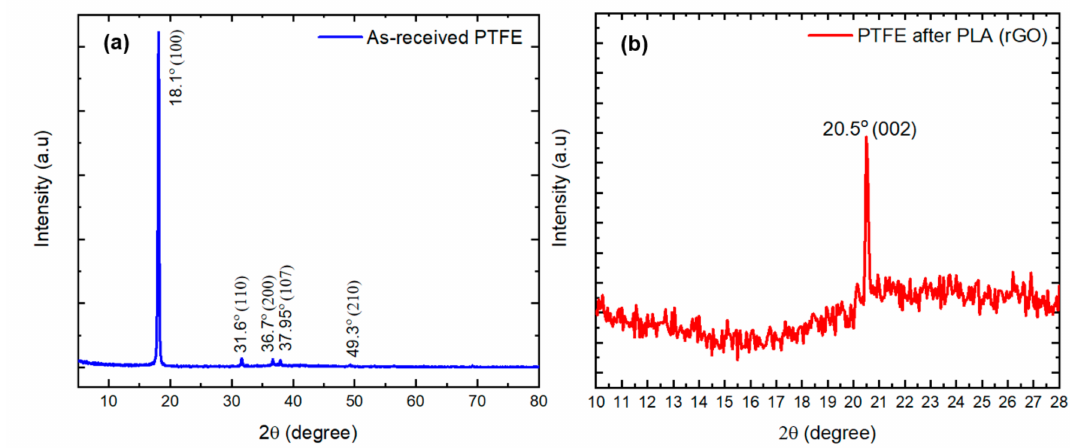
Figure 2. XRD pattern of ( a ) neat PTFE and ( b ) after laser annealing of PTFE.